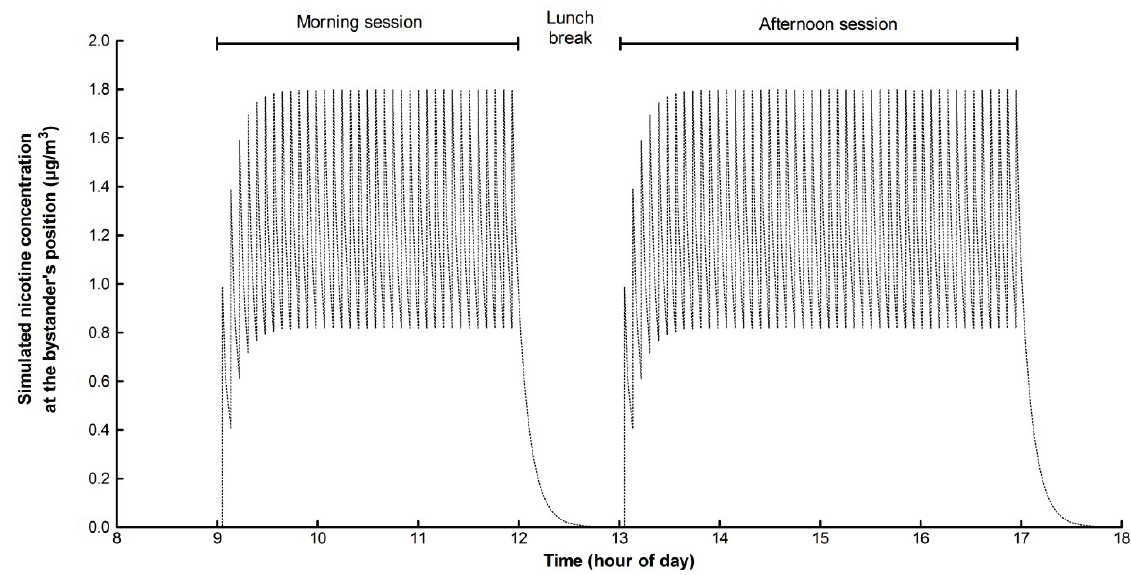
Figure 4. Cumulative effect of each single “puff” over an 8 h working day: calculation of e-cigarette user (the bystander) is seated 2 m from a colleague who “puffs” once every 5 min over an 8 h working day (9:00 h to 17:00 h with a one hour lunch break); the e-cigarette user inhales 30 µg nicotine per puff and exhales an aerosol which propagates in the indoor ambient air at 0.6 m/min; the exhaled aerosol deposits at a speed of 0.06 m/min and the room ventilation rate is 1.33 air changes per